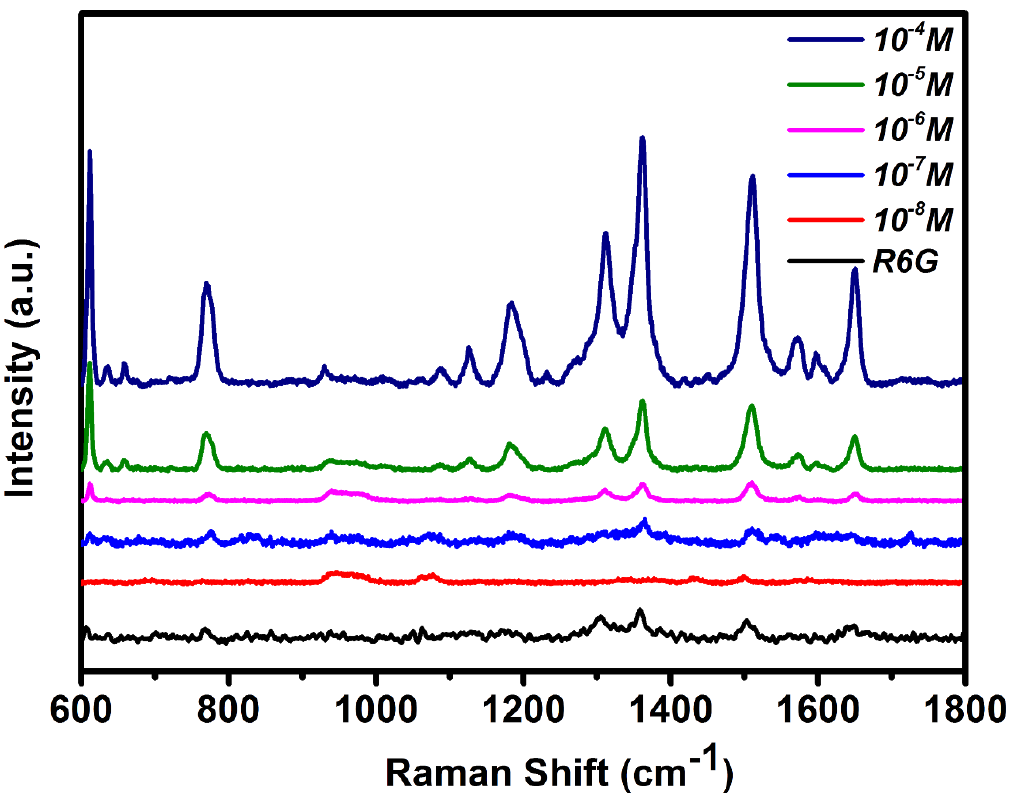
Figure 4. SERS images of 10 −4 -10 −8 M R6G adsorbed on the Ag-ZnO nanorod array substrate.